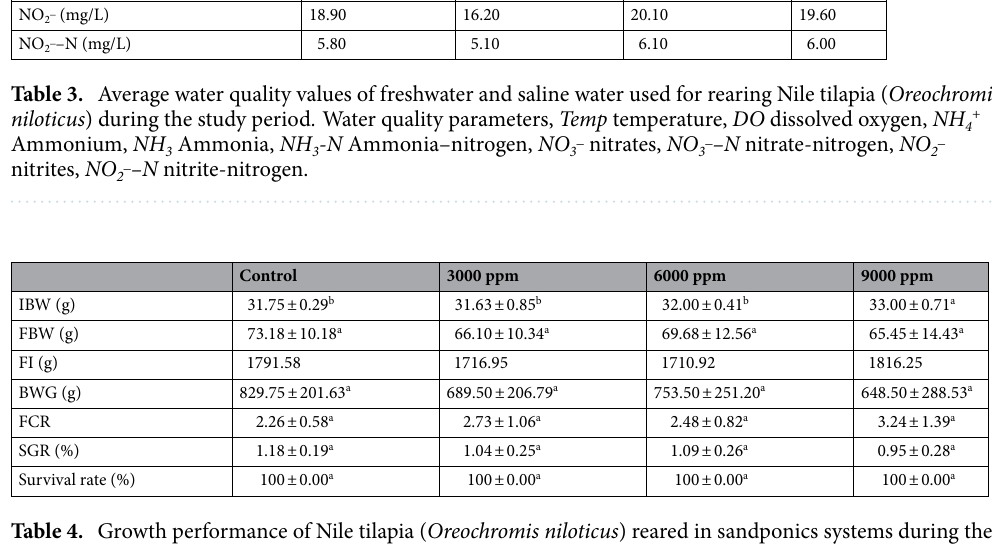
Table 4. Growth performance of Nile tilapia ( Oreochromis niloticus ) reared in sandponics systems during the study period. Data represented as mean ± SD (n = 3). Means in the same row having different lower superscript letters are significantly different at p < 0.05. IBW initial body weight, FBW final body weight, FI feed intake, BWG body weight gain, FCR feed conversion ratio, SGR specific growth